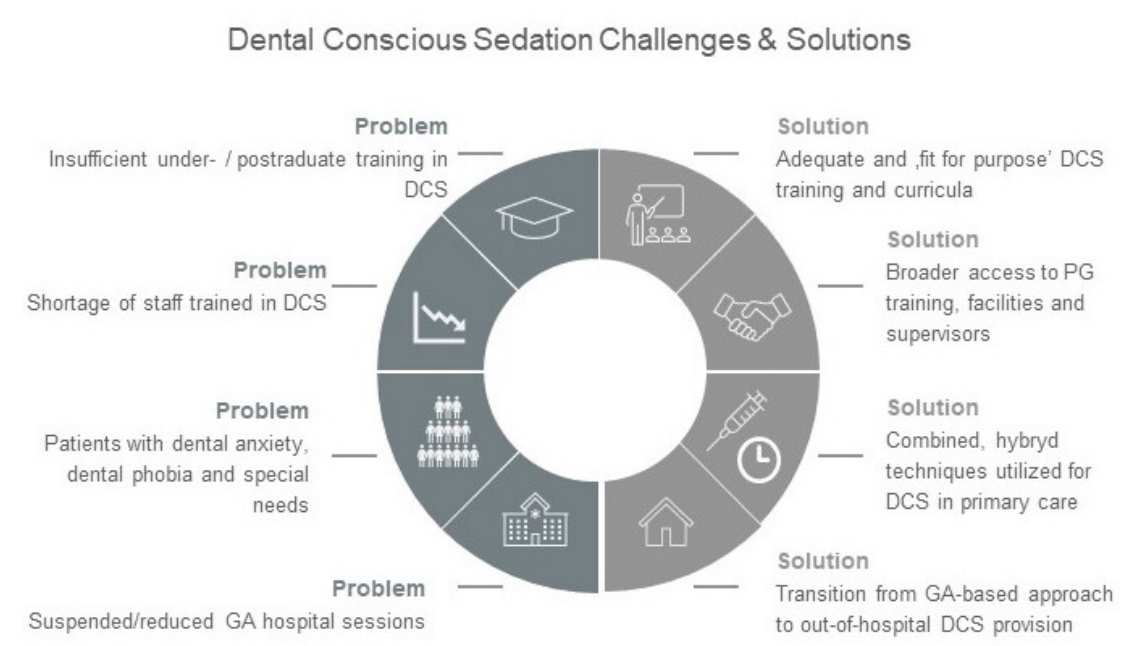
Figure 4. Provision of dental conscious sedation in primary and secondary care. Challenges and proposed solutions.